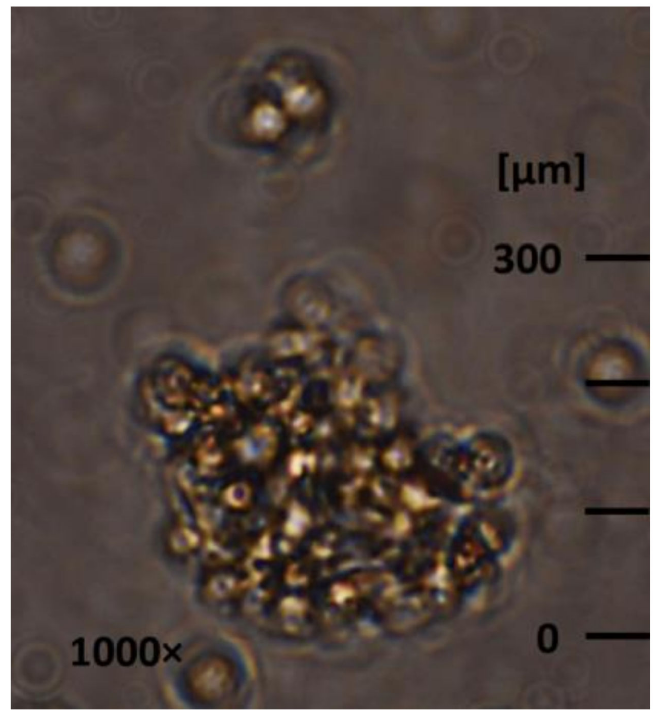
Figure 1. Free oil droplets and oil agglomerates in HTL-WW.